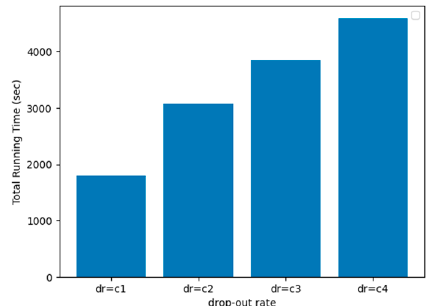
Figure 7. Total running time by cluster-based dropout.